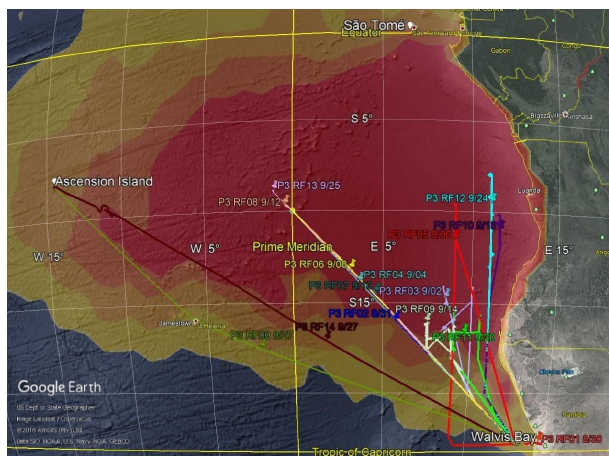
Figure 1. Map of the southeast Atlantic (SEA) region with flight paths from the NASA P-3B during ORACLES deployment of 2016. Climatological aerosol optical depth from MODIS for September (2001–2013) is overlaid as colored shaded contours (yellow shading represents an AOD of 0.25, with deep red shading for 0.5, adapted from Zuidema et al.,